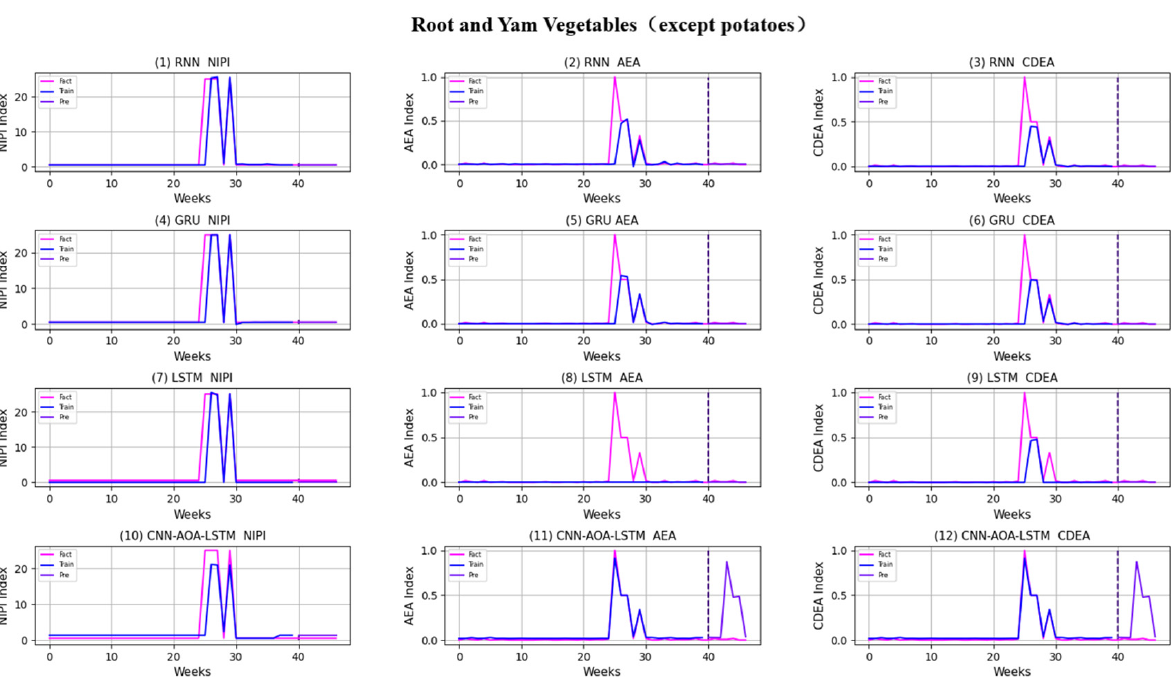
Figure 12. Prediction results of indexes of melon vegetables.